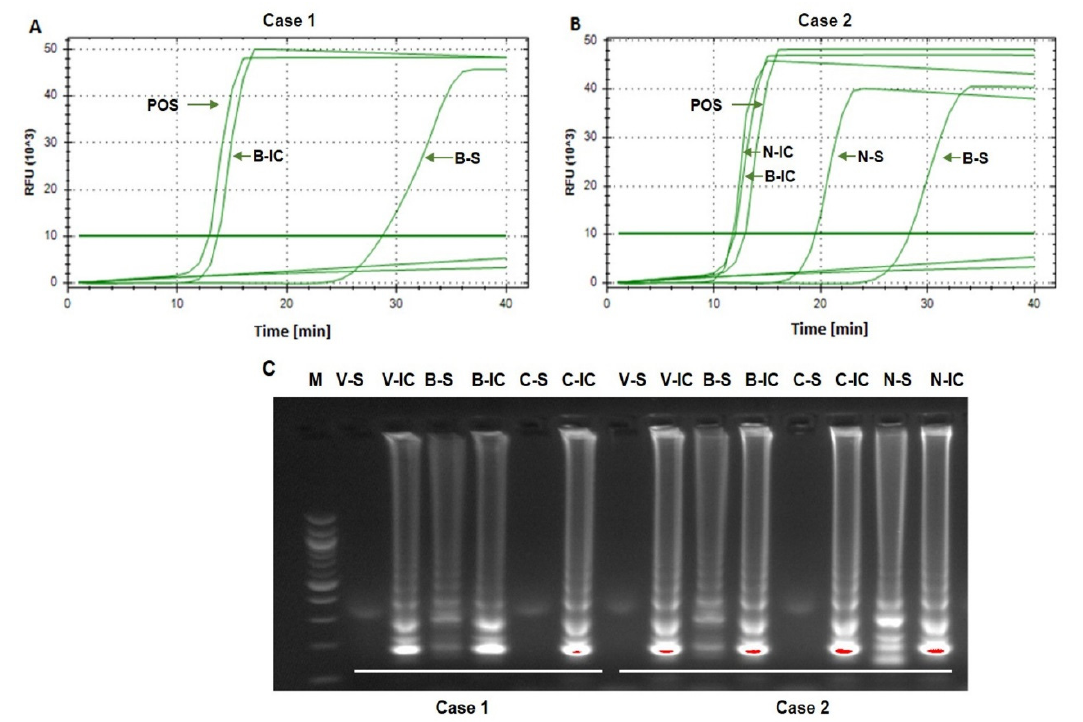
Figure 1. SARS-CoV-2 detection in postmortem collected samples. The real-time SARS-CoV-2 de- tection using Genomtec ® SARS-CoV-2 EvaGreen ® RT-LAMP CE-IVD Duo Kit from two clinical cases